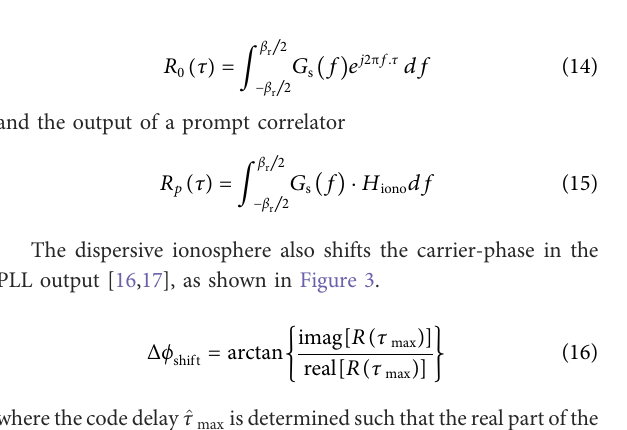
FIGURE 3 Representation of carrier-phase tracking